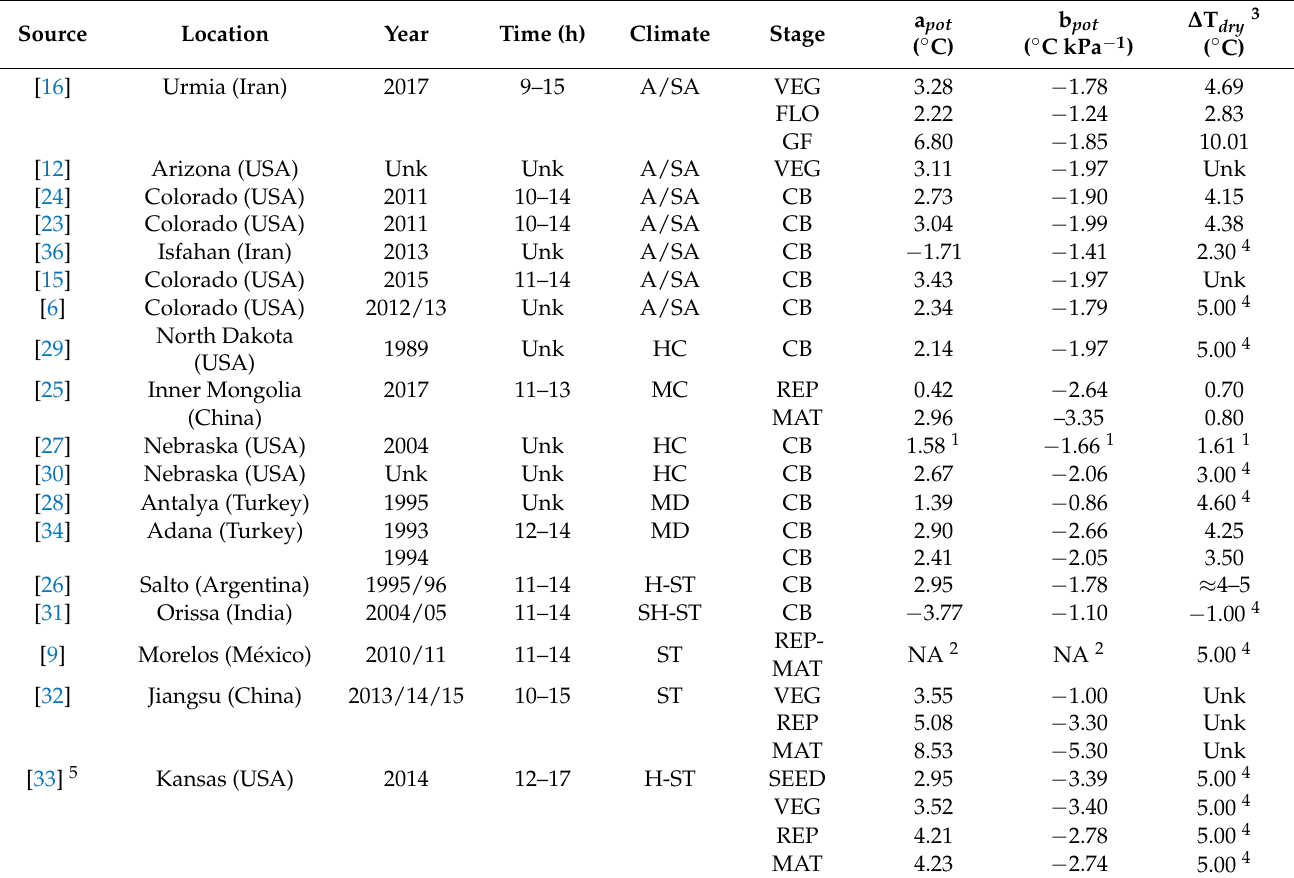
Table 4. Summary of the reference baselines previously determined for computing empirical CWSI in maize. Unk = un- known, A/SA = arid/semiarid, HC = humid continental, MC = monsoon continental, MD = Mediterranean, SH- ST = subhumid-subtropical, H-ST = humid-subtropical, VEG = vegetative, FLO = flowering, GF = grain-filling, CB = common baseline, REP = reproductive; MAT = maturation, SEED = seedling, NA = not